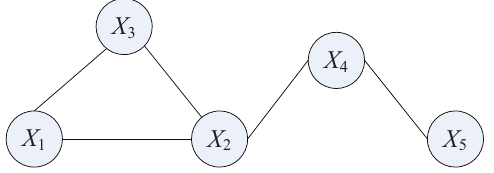
Figure 4. Illustration of the network structure of MRF.